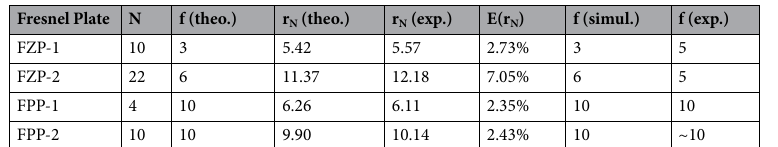
Table 1. Fresnel Plates parameters (distances in µ